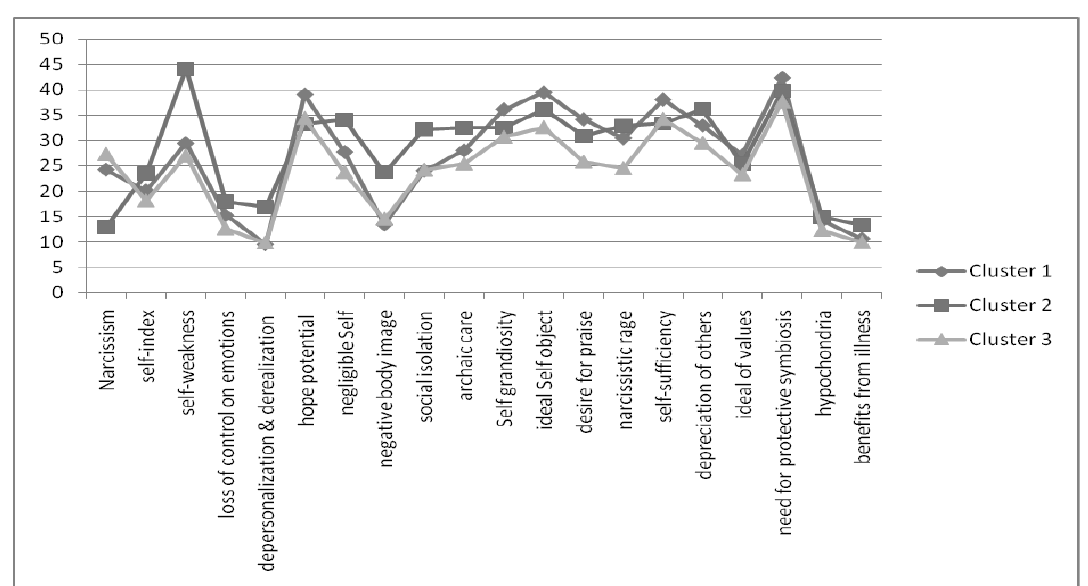
The de (cid:192) ned narcissistic self-regulation types (cluster analysis). Source: own